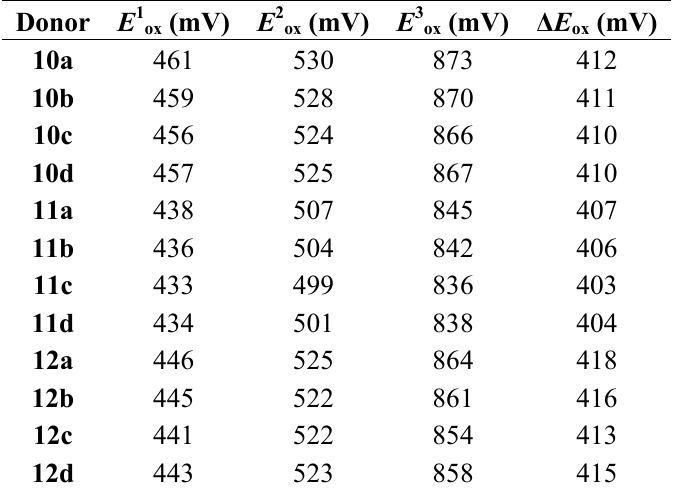
Table 1. Potential of unsymmetrically benzene-fused bis tetrathiafulvalenes 10a – 12d .